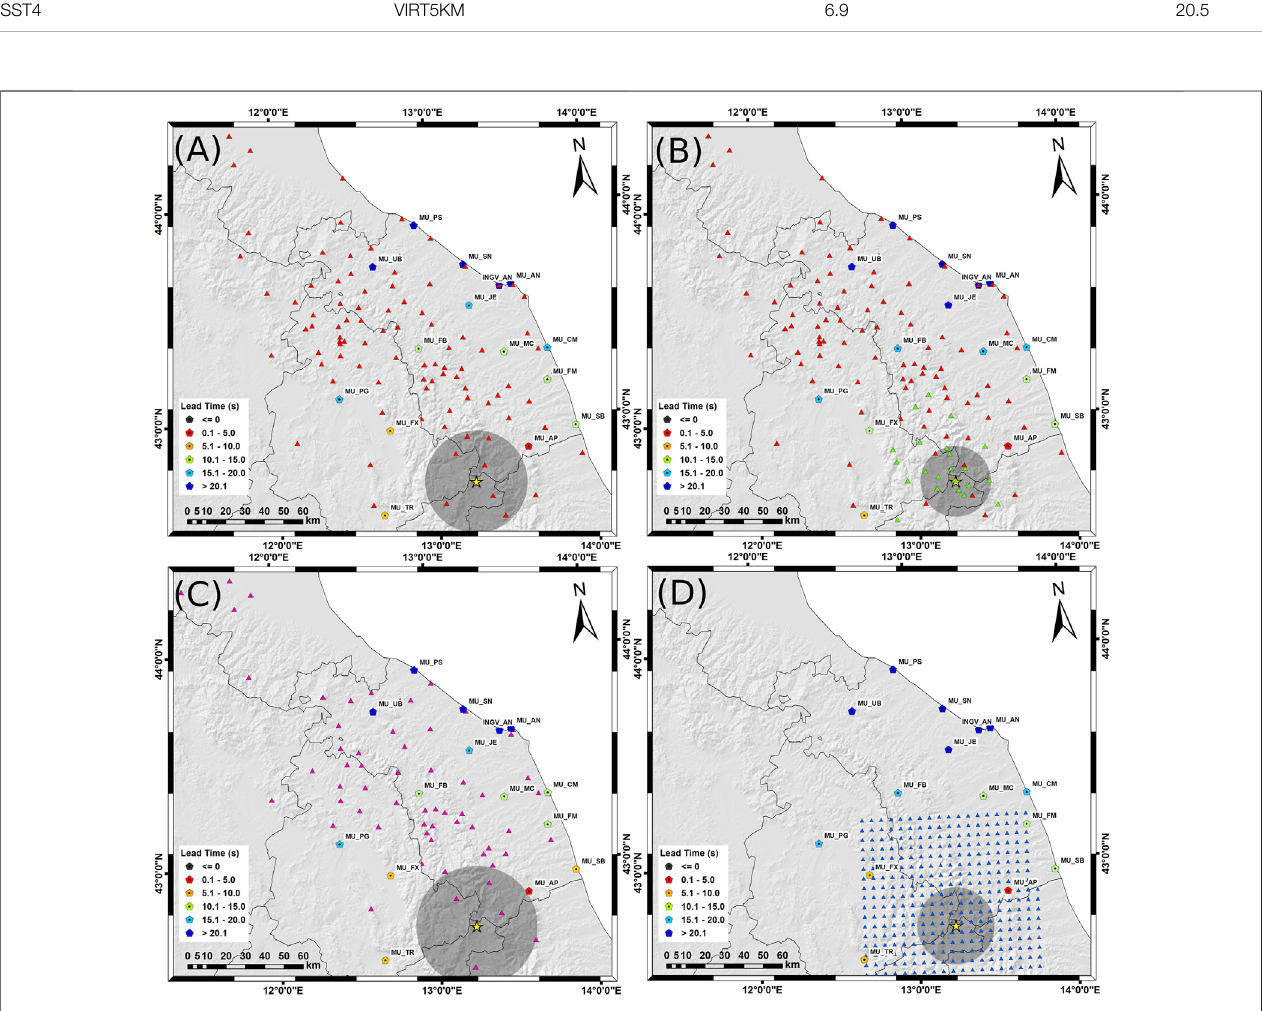
FIGURE 5 | EDS of the EEW response relative to a single source. Yellow star: location of the Mw 6.0 August 24, 2016 earthquake. Gray circle: Blind Zone. Pentagon: Targets. Legend: color map of the LT (s) linked to the targets. (A) SST1 test. Red triangles: PSN15 network. (B) SST2 test. Red triangles: PSN15 network; green triangles: TSN16. (C) SST3 test. Purple triangles: ASN20. (D) SST4 test. Blue triangles: 5 km inter-distance virtual network.